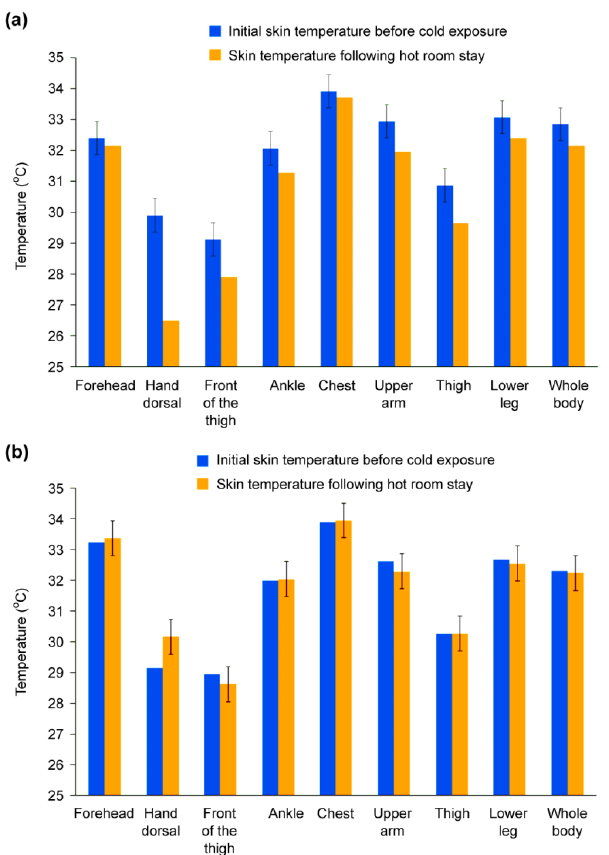
Figure 6. Mean skin temperatures of individual body parts and the whole body under ( a ) 18 °C and ( b ) 24 °C.